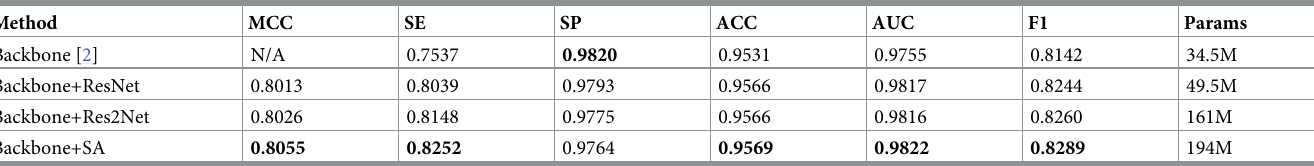
Table 5. Ablation study segmentation results on the DRIVE dataset. Method